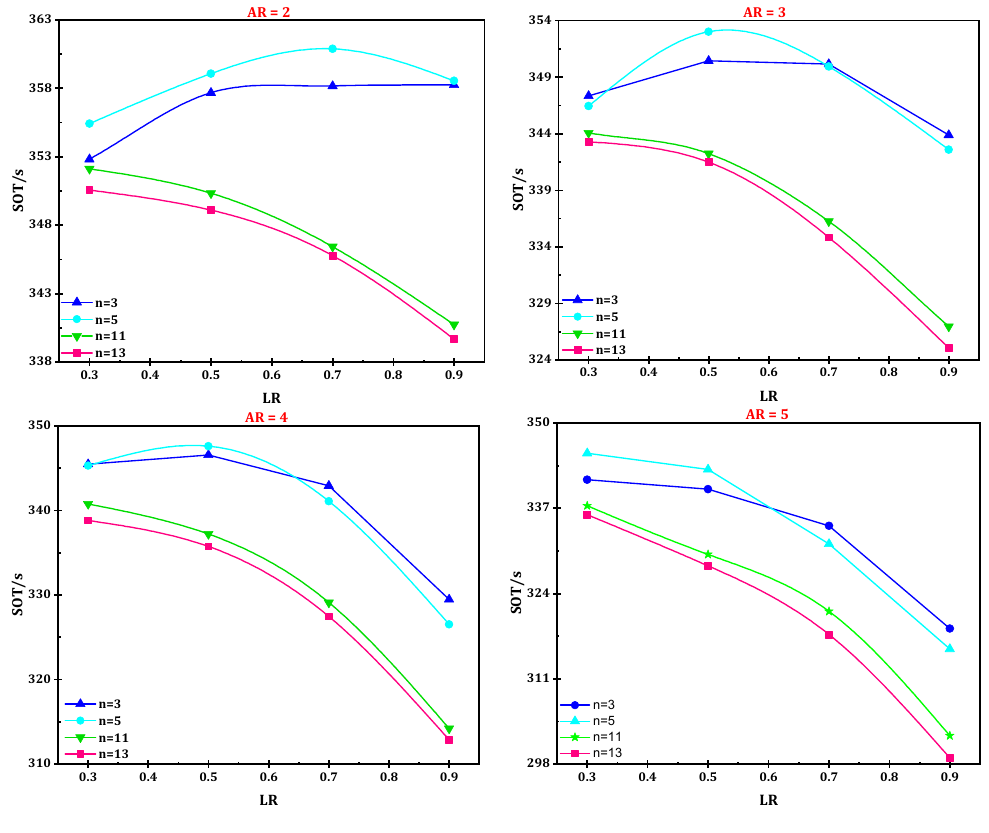
Figure 10. Optimum fins number at different AR.